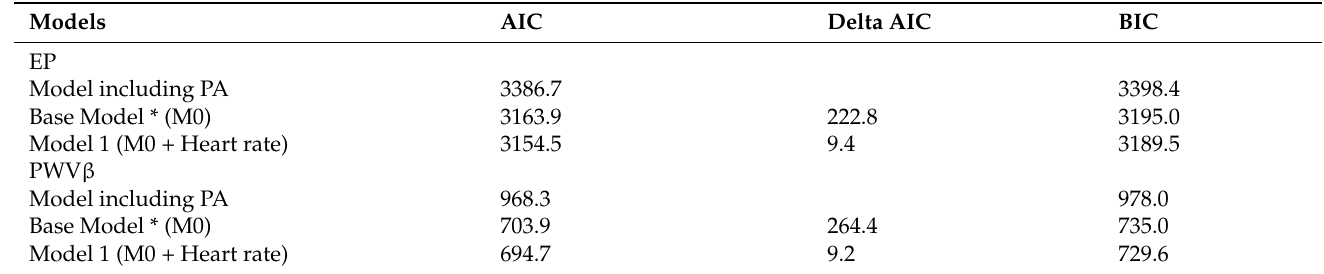
Table 4. Akaike information criterion (AIC), Delta AIC, and Bayesian information criterion (BIC) for the linear regression analyses having EP and PWV β as dependent